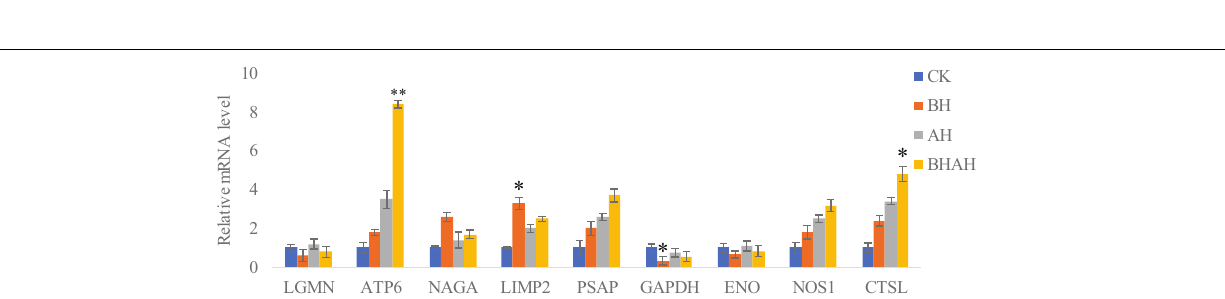
Frontiers in Marine Science |